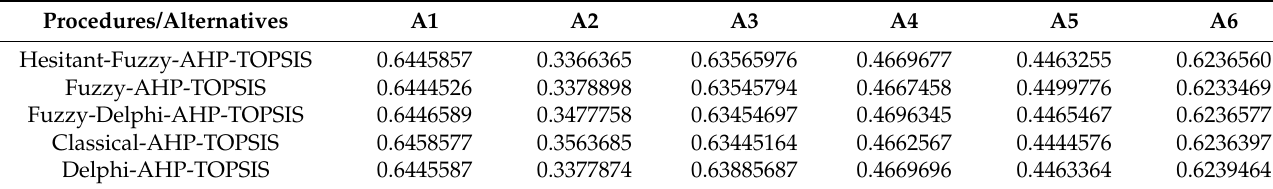
Table 11. Comparative